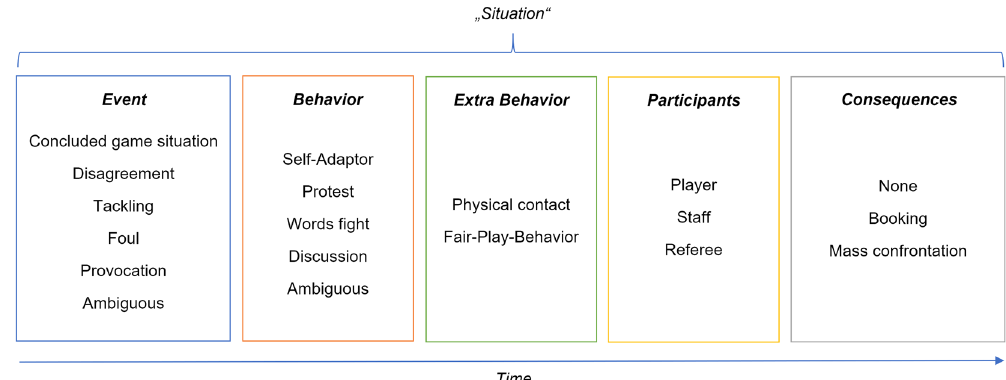
Fig. 1 “ Analysis System for Emotional Behavior in Football ” (ASEB-F). The system consists of consecutive categories that we developed for this study. The system provides timing for analysis of situations, which are used to describe the initial trigger for the situation itself (event), the resulting visually observable nonverbal reaction (behavior & extra behavior), involved agents (participants) and the outcome (consequences). One factor from each of the categories “ Event ” , “ Behavior ” and “ Consequences ” and at least one factor from the categories “ Extra Behavior ” and “ Participants ” must be existent for the situation to qualify for documentation during the analysis of a